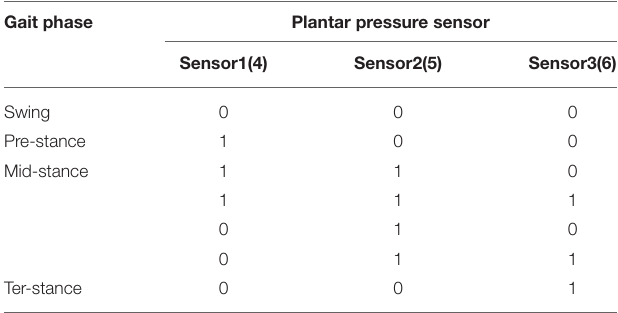
TABLE 2 | The relationship between the gait phase and the state of the thin-film pressure